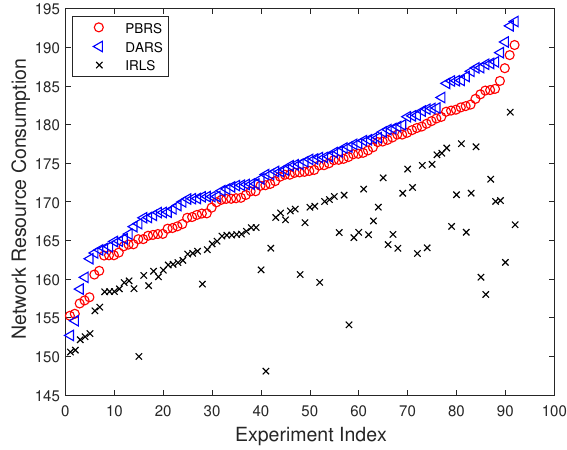
Figure 3. Network resource consumption.